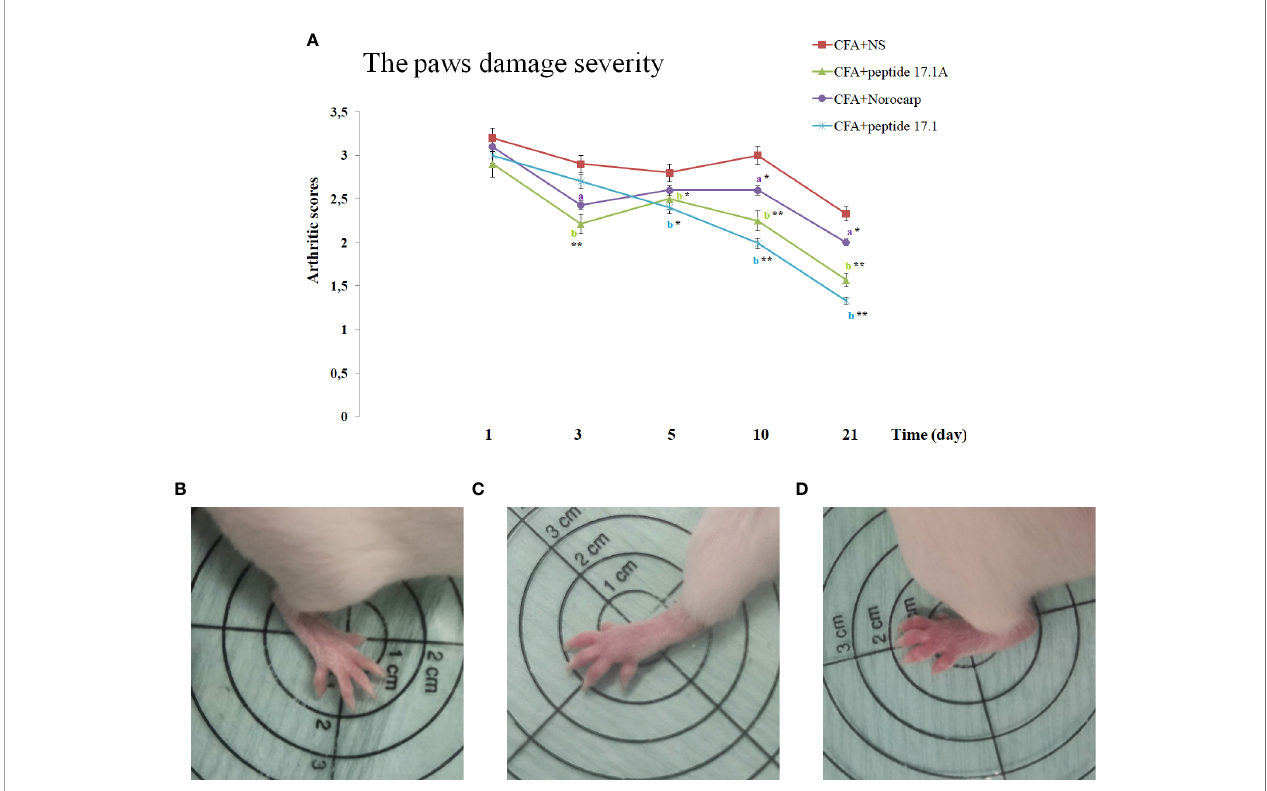
FIGURE 4 | . Development of experimental arthritis induced by CFA in CD-1 mice. (A) - evaluation of the paw edema severity in CFA-induced arthritis in mice of control, CFA-control (treatment of NS), 17.1A, Norocarp, 17.1 (CFA — complete Freund ’ s adjuvant; NS — normal saline). All data are presented as mean ± SEM for at least three independent replicates. a p < 0.05, b p < 0.01 vs CFA+NS; *p < 0.05, **p < 0.01 vs baseline on 1 day. (B) – Intact paw (score 0); (C) – paw on 3 days after CFA-induced arthritis with peptide 17.1A (score 2); (D) – paw on 3 days after CFA-induced arthritis with NS (score 3). (n = 10 in each group).